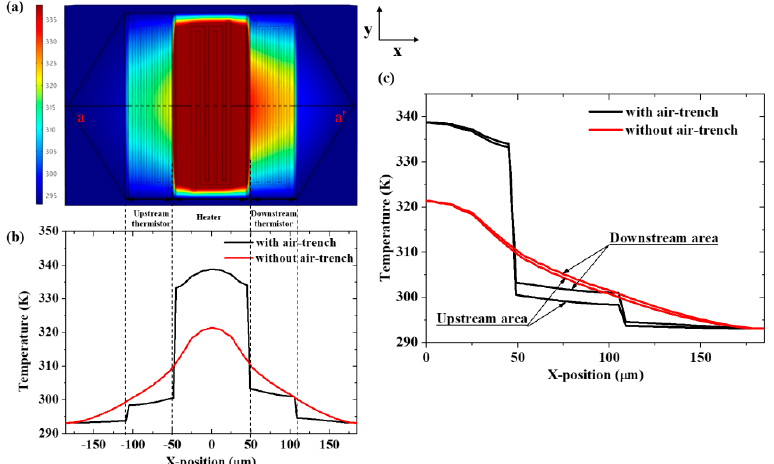
Figure 3. Simulation result of the gas flow sensor with air-trench and without air-trench. ( a ) Temperature distribution diagram of the composite thin film. ( b ) Composite thin film temperature distribution diagram of simulation model. ( c ) Composite thin film temperature distribution at the upstream and downstream symmetrical position.